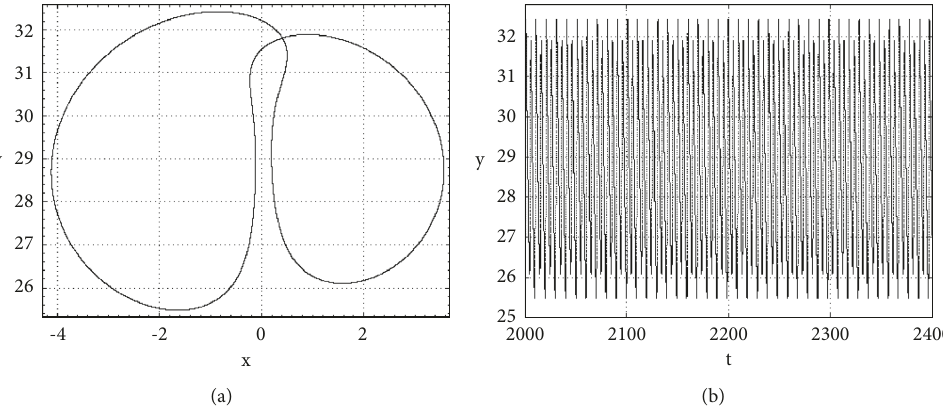
Figure 25: Phase portrait (a) and time series (b) of the system when the value of control parameters kf � 0.02 − 0.035 and to � 0.5. The rest of parameters are x0 � 0.01; y0 � 0.01; z0 � 20; c � 30; u � 0.009; v � 0.005; beta � 0.03; σ � 3.105; (a) T 3 �